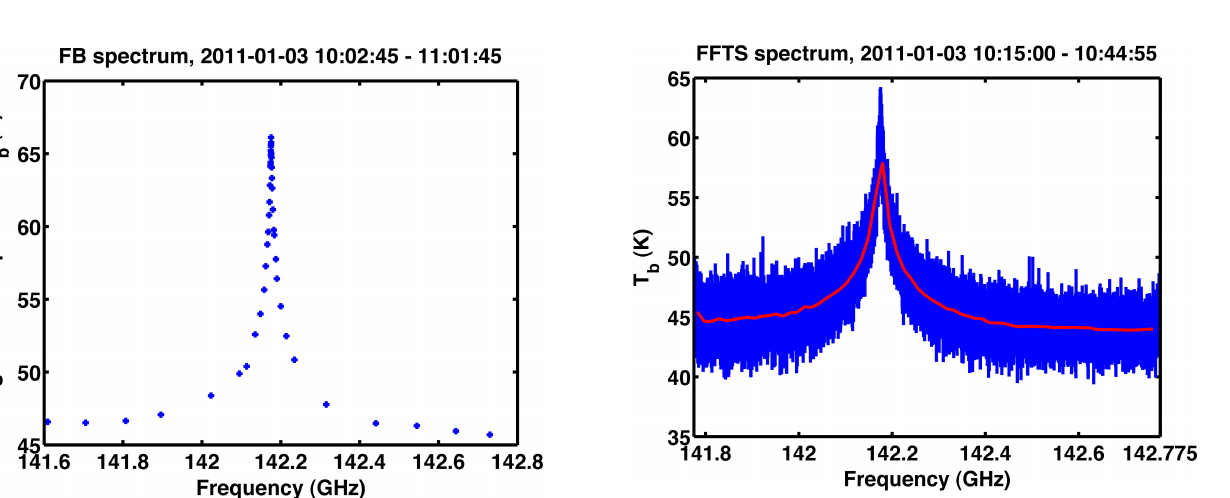
Figure 2. Ozone spectrum line at 142GHz recorded by the Acqiris FFT spectrometer at Bern on a winter day. The integration time is 30min. The red line represents the frequency binned. Table 1. GROMOS instrument